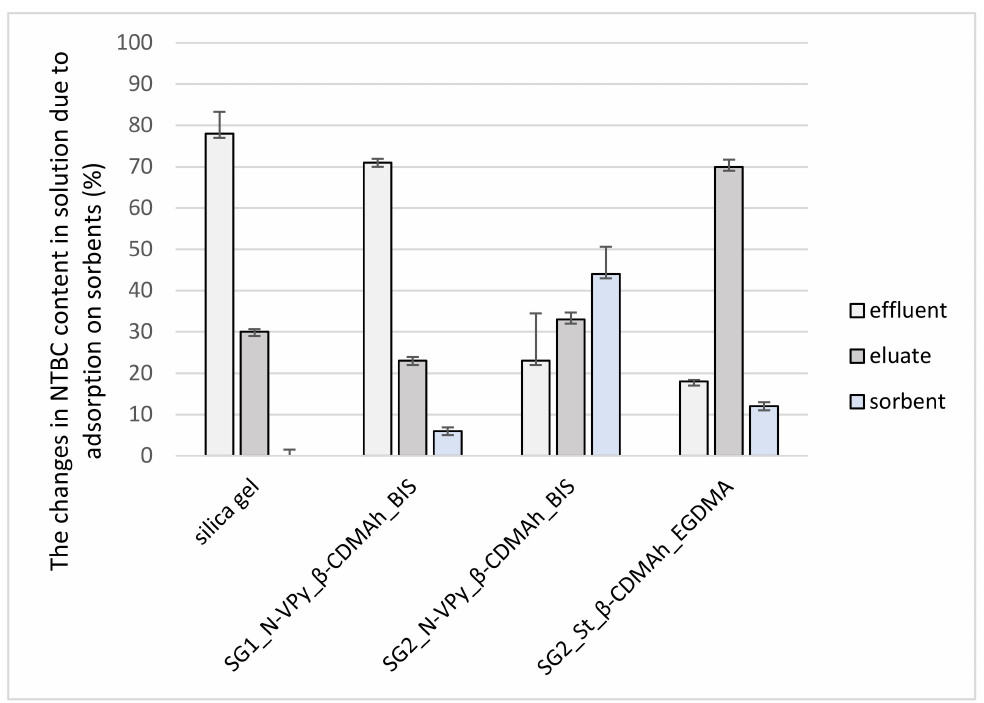
Figure 7. Changes in NTBC content in solution following adsorption to commercially available silica gel and the developed